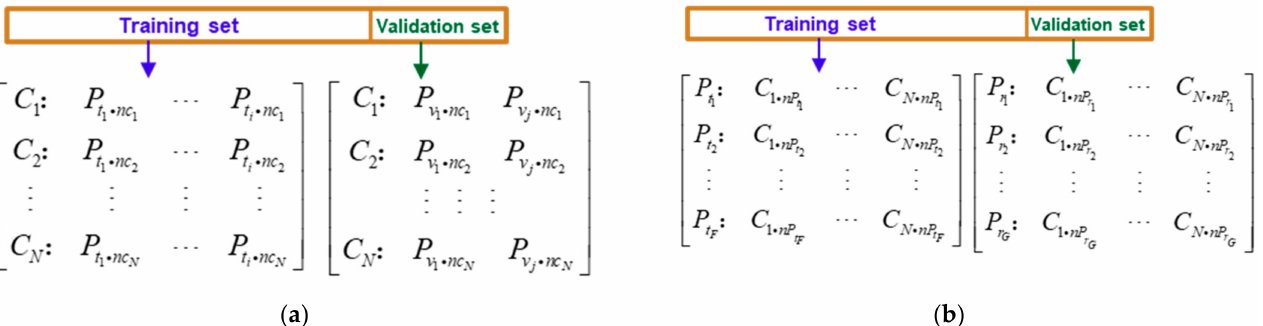
Figure 2. The execution process of the training set, validation set, and test set in object detection algorithm.